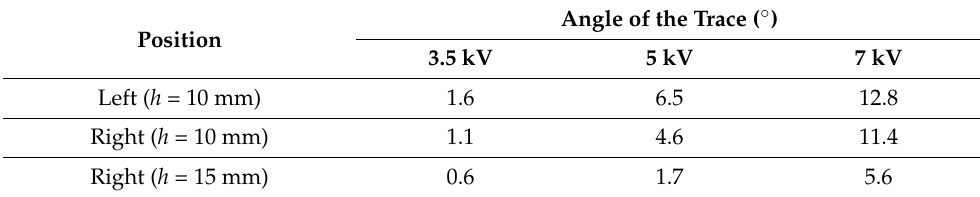
Table 1. Angle of the trace on different voltages and